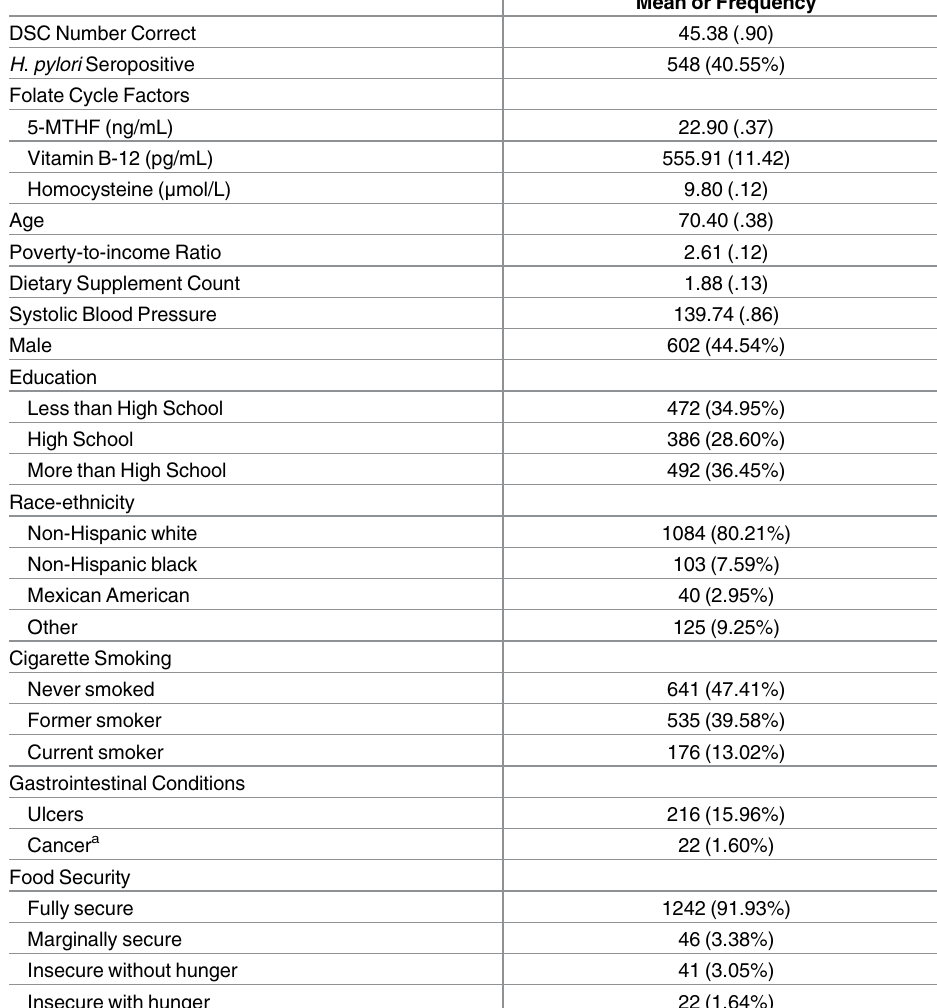
Table 1. Weighted summarystatistics of U.S. adults 60 to 85-year-olds, National Health and Nutrition Examination Survey